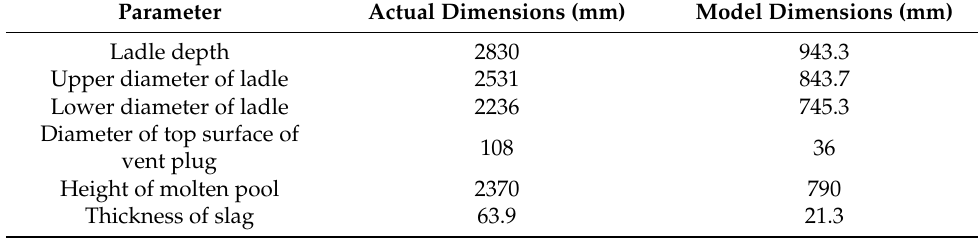
Table 1. Size parameters of ladle prototype and model.